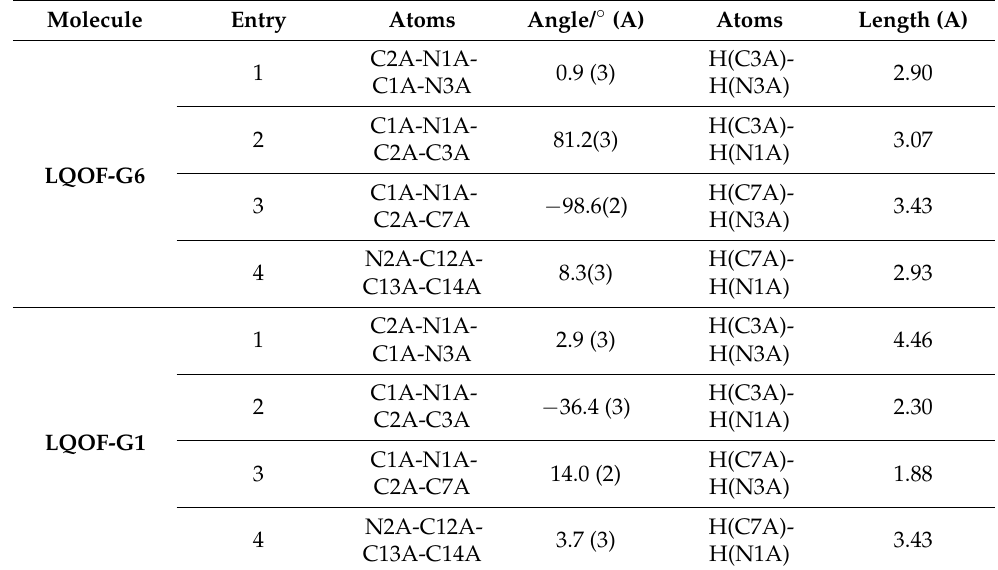
Table 3. Torsion Angles and bond spatial lengths for LQOF-G6 and LQOF-G1 { ◦ (Å)}.